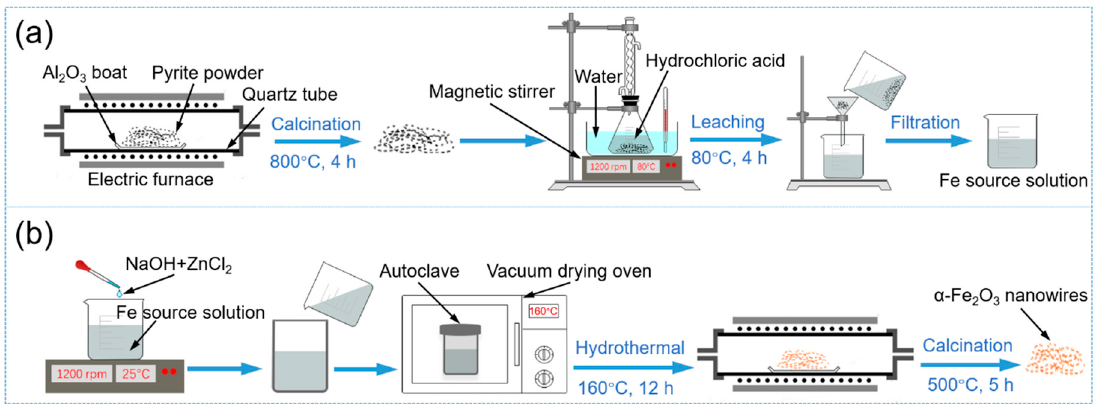
Figure 1. Schematic diagram of ( a ) the preparation process of Fe source solution and ( b ) preparation process of Zn-doped α -Fe 2 O 3 nanowires .